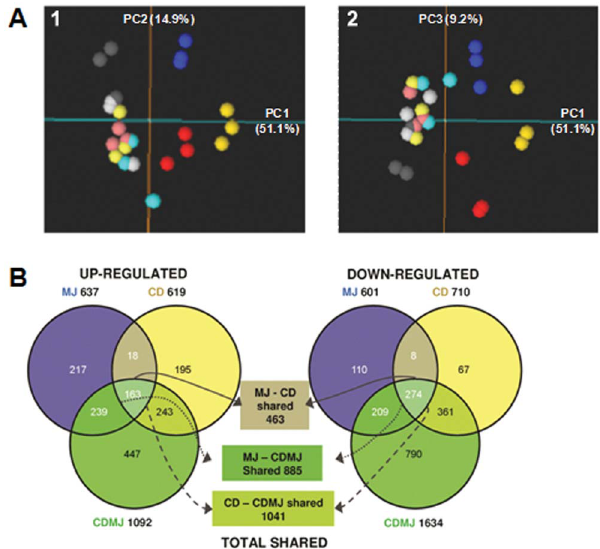
Figure 2. A, PCA over the expression dataset after the average of the redundant probesets expression values. 1, PC1 vs PC2; 2, PC1 vs PC3. Grey, Control; Blue, MJ (methyl jasmonate); Red, CD (cyclodextrins); Yellow, CD and MJ (cyclodextrins and methyl jasmo- nate); Light colors, just before cell treatments; Dark colors, 24 h cell treatments. B, Genes significantly regulated by elicitor treat- ments. C, control; MJ, methyl jasmonate; CD, cyclodextrins; CDMJ, cyclodextrins and methyl jasmonate. Venn diagram summary of significantly regulated transcripts. Non-redundant significant transcripts were obtained from probesets showing an at least 2-fold change and 5% FDR and P -value , 0.05 for model variable in the corresponding control versus treatment 24 h series maSigPro comparison. Left side, up-regulated transcripts in each treatment; Right side, down-regulated transcripts in each treatment; Center, summary of significantly regulated transcripts shared by any two treatments.